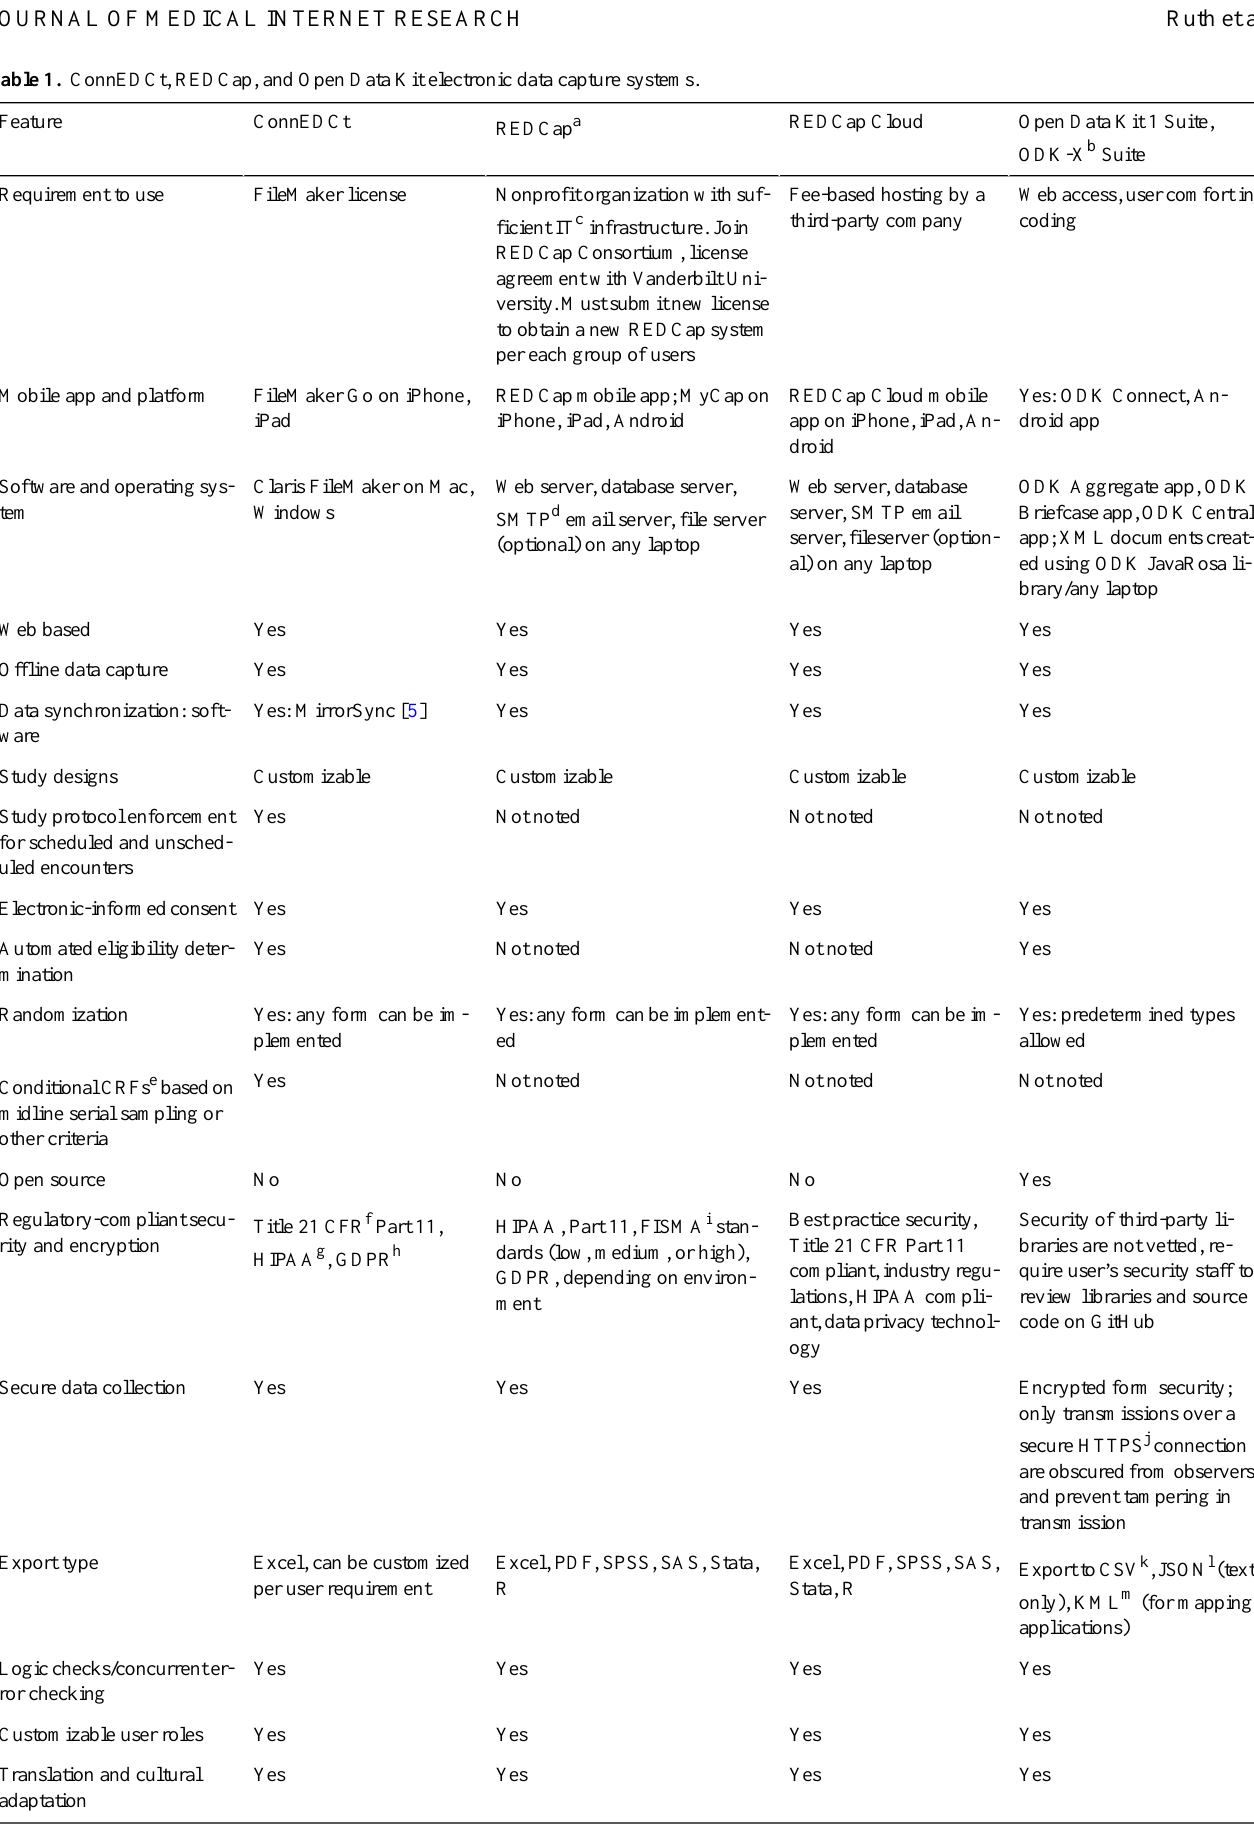
Table 1. ConnEDCt, REDCap, and Open Data Kit electronic data capture